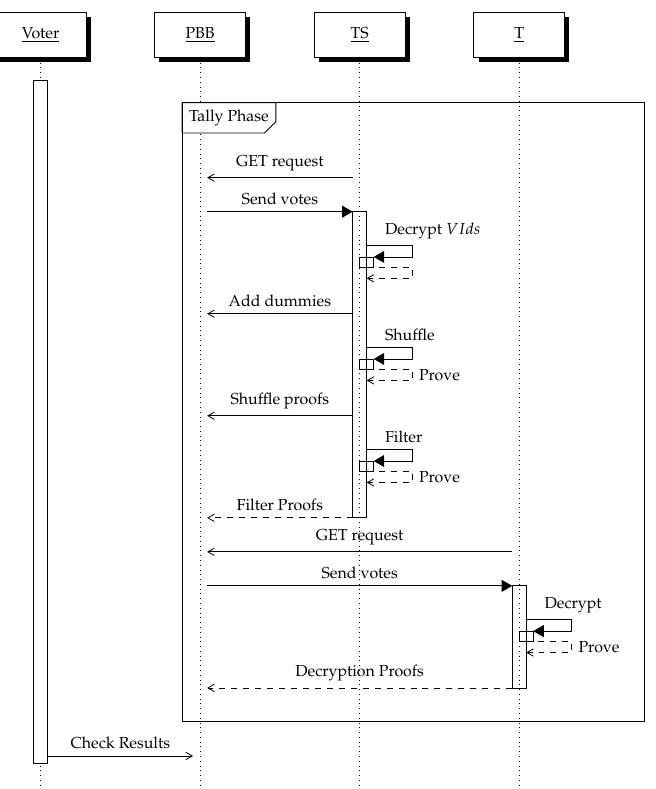
Figure 2. Diagram showing a summary of the tallying phase, involving the voters, the public bulletin board, the tallying server and the